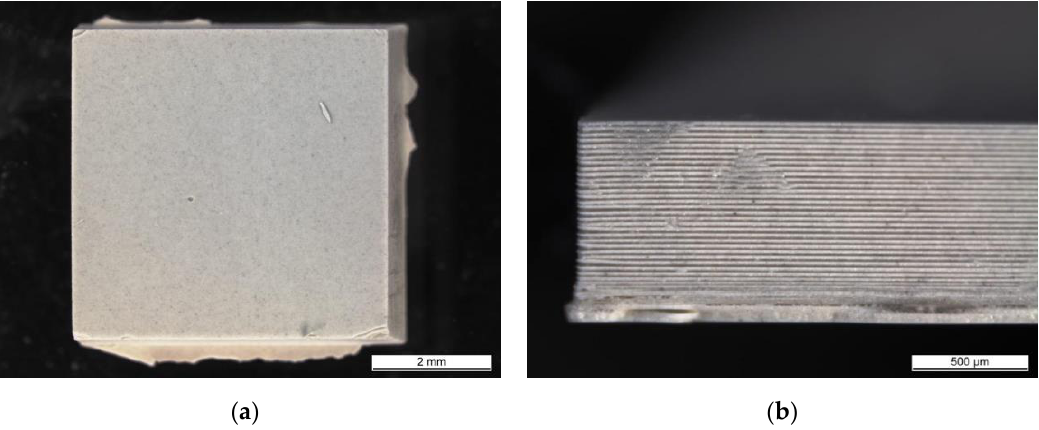
Figure 6. AlN green body 3D printed using printing parameters PP-A and 40 vol % dispersion and 0.5 wt % TPO-L. ( a ) top view, ( b ) side view.